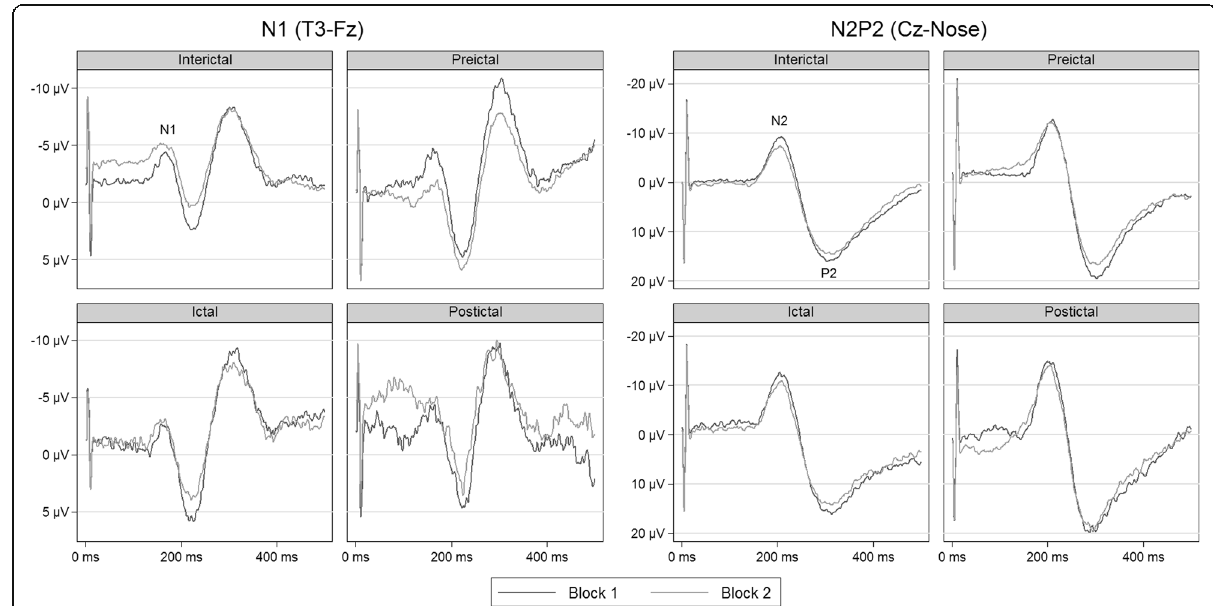
Fig. 1 Grand average of the LEP-traces by phase. Habituation was present in all phases at both LEP-components but ictal and postictal N1, and postictal N2P2. The amplitudes in the figures are smaller than those presented in Table 2 due to slightly different LEP-latencies between participants